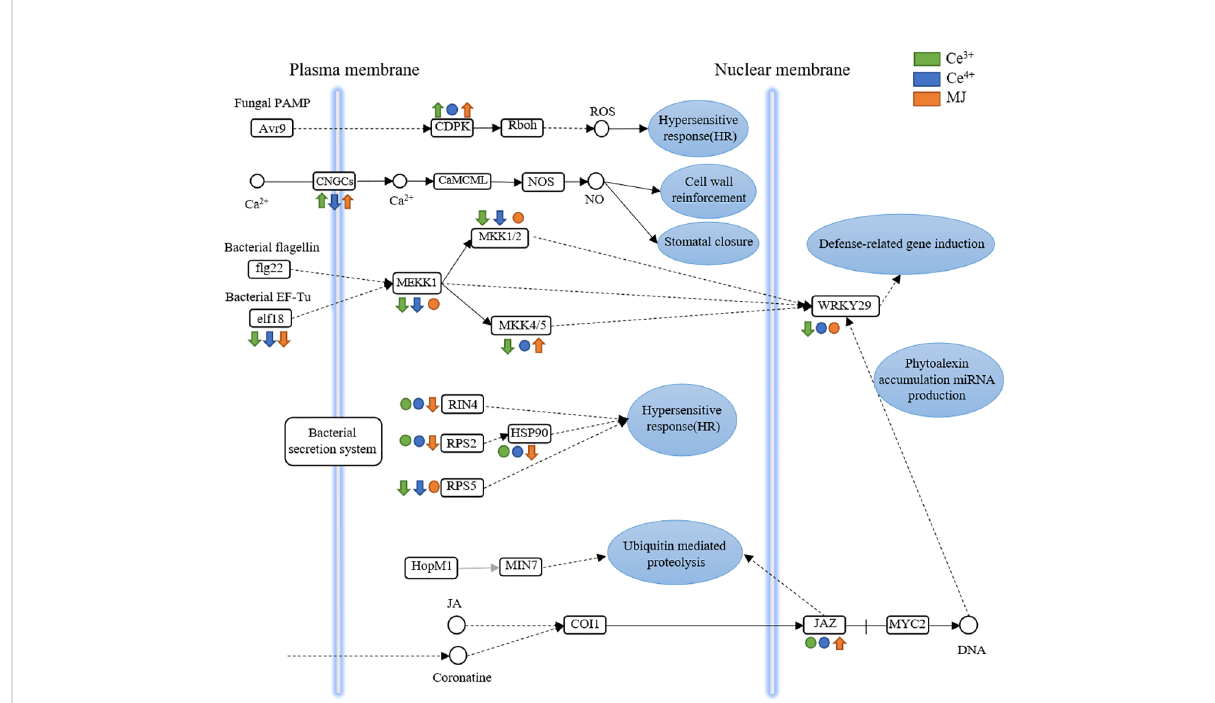
FIGURE 8 DEGs assigned to plant-pathogen interaction in C6h-vs-CeA6h, C6h-vs-CeB6h and C6h-vs-M6h. Green is elicited by Ce3+, blue is Ce4+, orange is MJ. The up arrows indicate the upregulation of gene expression; the down arrows indicate the downregulation of gene expression; the circles indicate unchanged